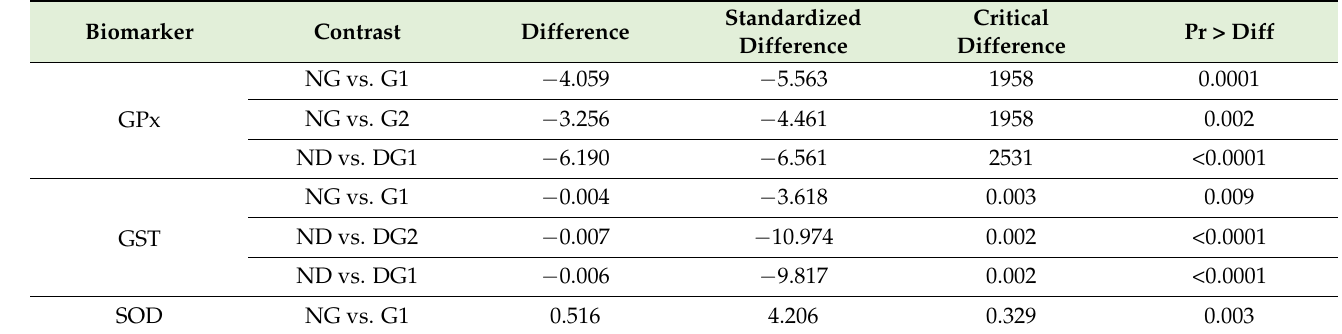
Table 4. Results of one-way ANOVA and Dunnett’s post-hoc test on GPx (glutathione peroxidase),